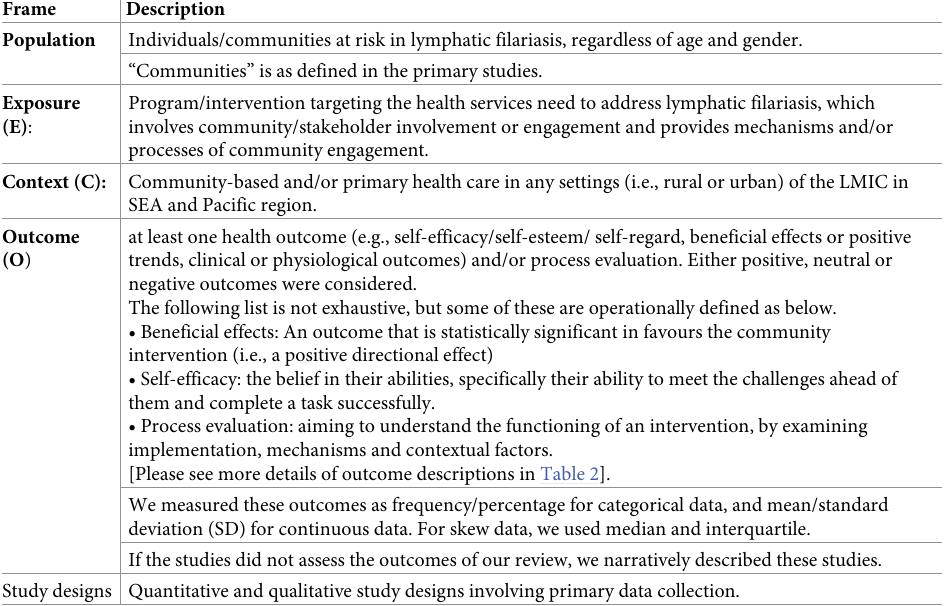
Table 1. Inclusion